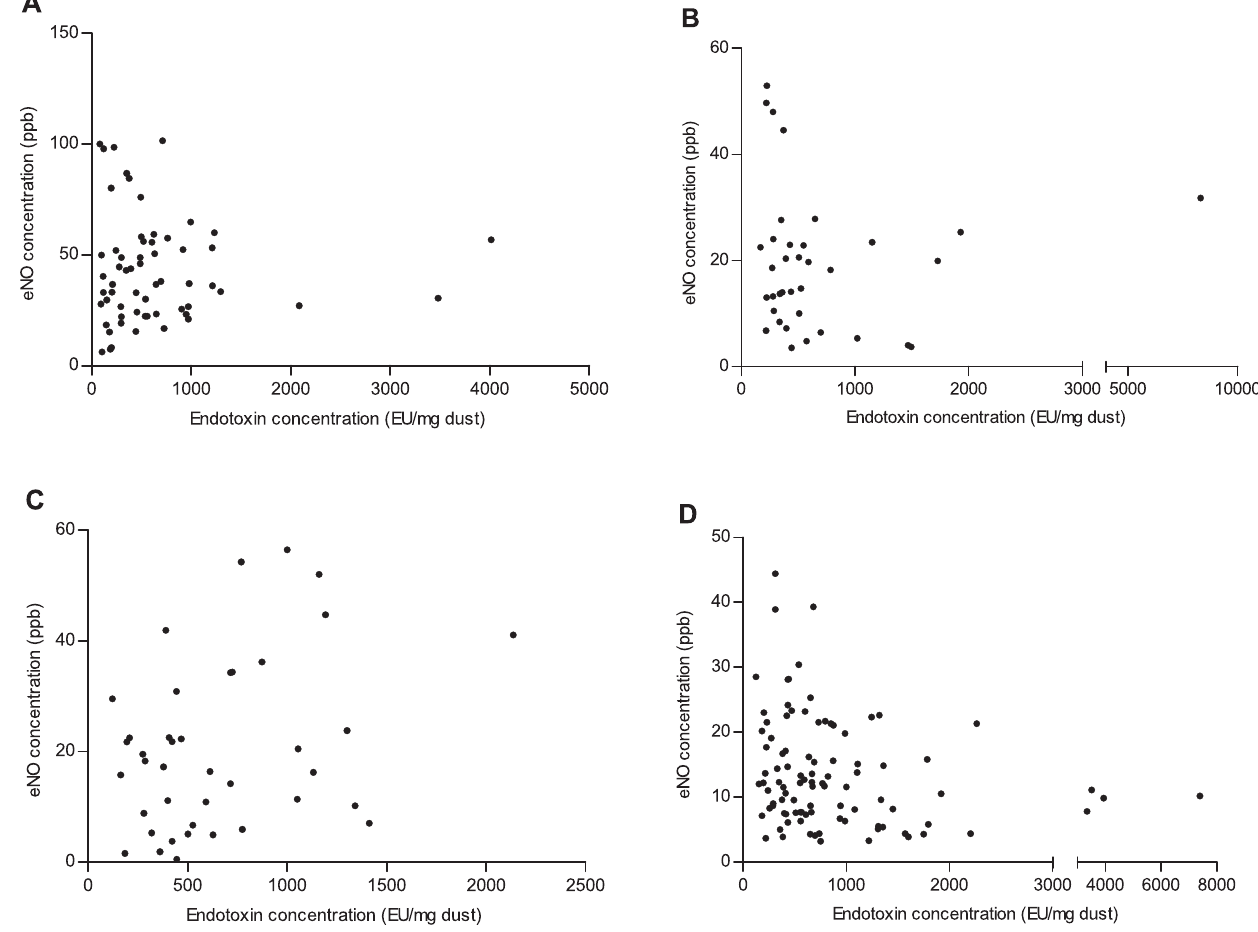
Figure 5. Associations between endotoxin concentrations and exhaled nitric oxide levels in children. (A) asthma group; (B) allergic rhinitis group; (C) AS + AR group; (D) control group.